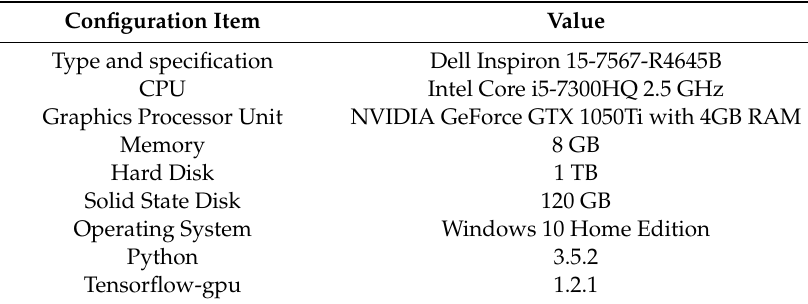
Table 4. Software and hardware configurations.